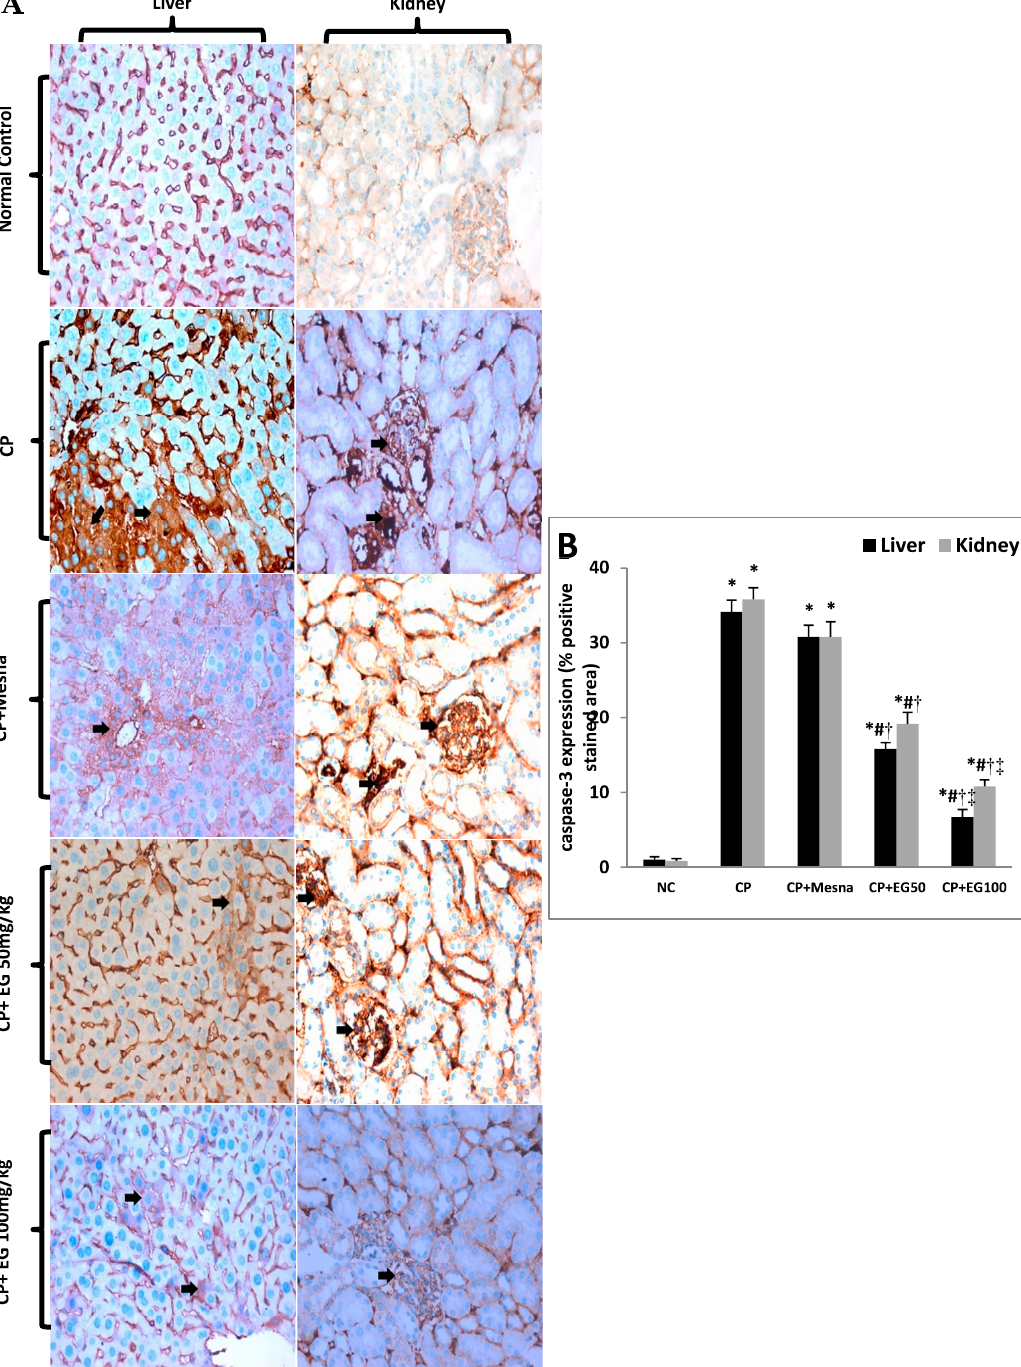
Figure 6. E ff ect of EG pretreatment on IHC expression of caspase-3 ( × 400, black arrows represent localization of positively stained brown cytoplasm with ignored cross reaction in sinusoids as appeared in normal control section) ( A ) and semi-quantitative estimation of caspase-3 positively stained cells in hepatic and renal tissues of CP-treated mice.